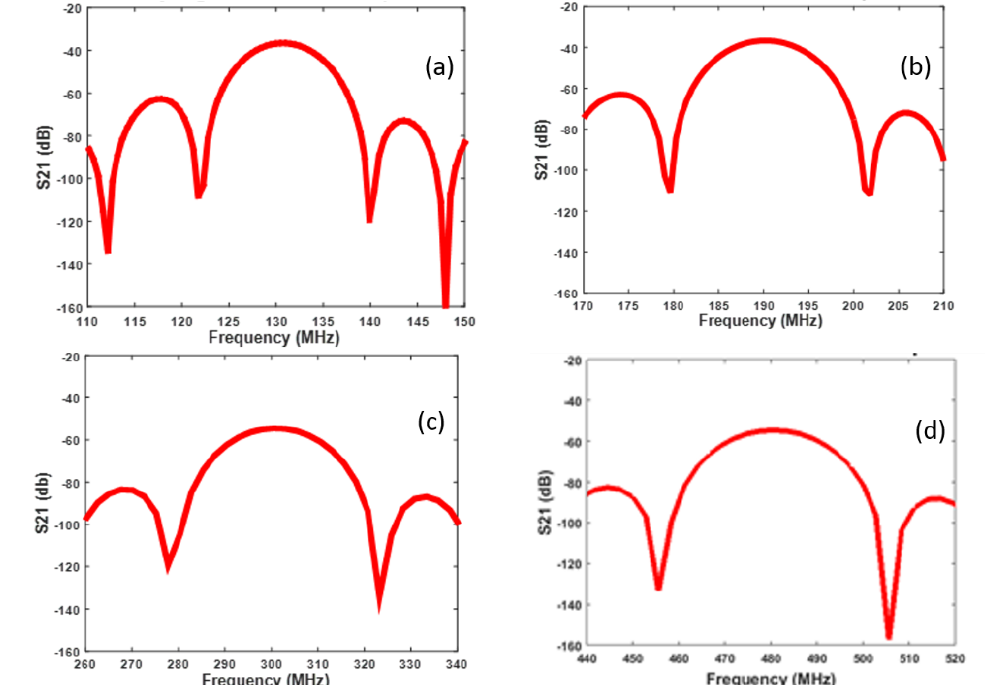
Figure 10. The S 21 of the fundamental ( a ) Rayleigh; ( b ) Sezawa; and third harmonic of the ( c ) Rayleigh; and ( d ) Sezawa mode vs. frequency.